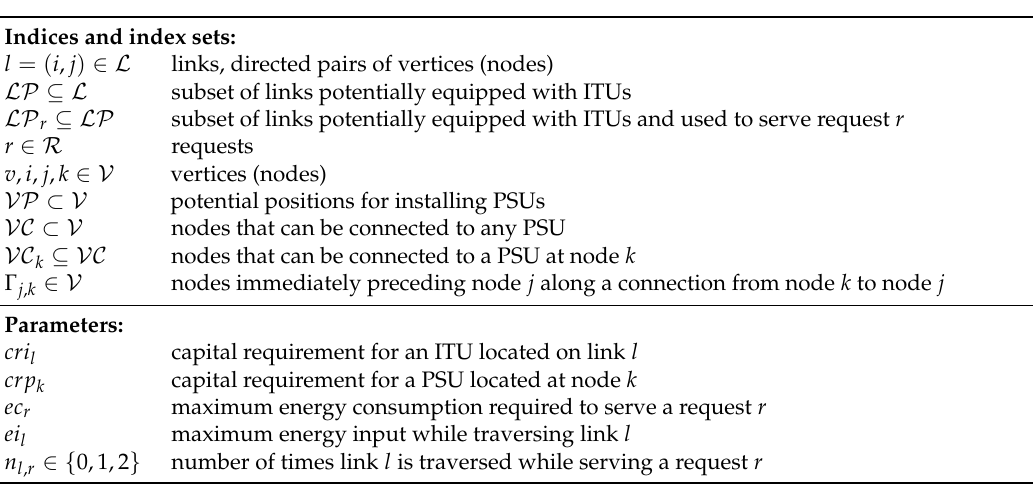
Table 1. Notations used in the